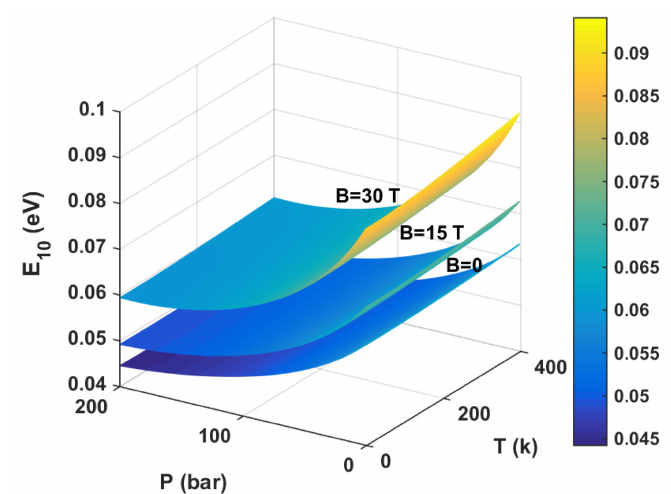
Figure 2. The energy difference E 10 of morse QWs are depicted as a function of hydrostatic pressure P , temperature T , and applied magnetic field B .